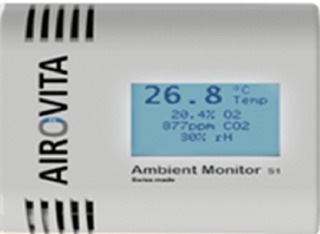
Figure 1. CO 2 /oxygen/temperature and humidity monitor (source: http://www.airovita.com/).